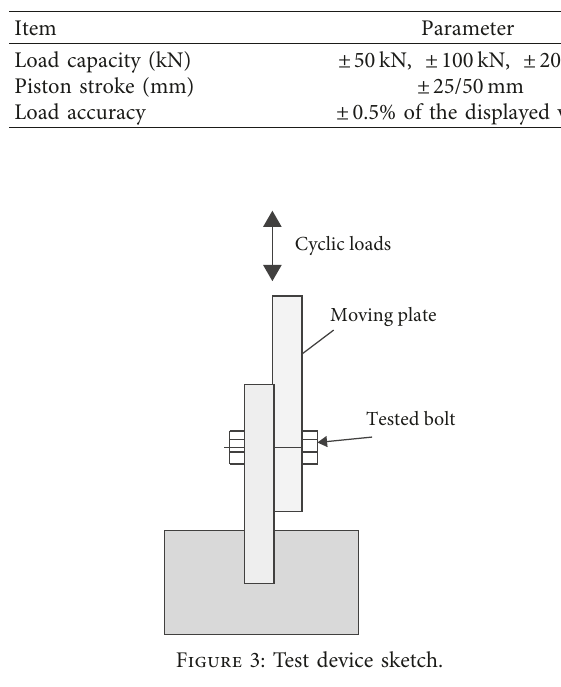
Figure 2: Electrohydraulic servo fatigue tester. Table 1: Tester specifications.